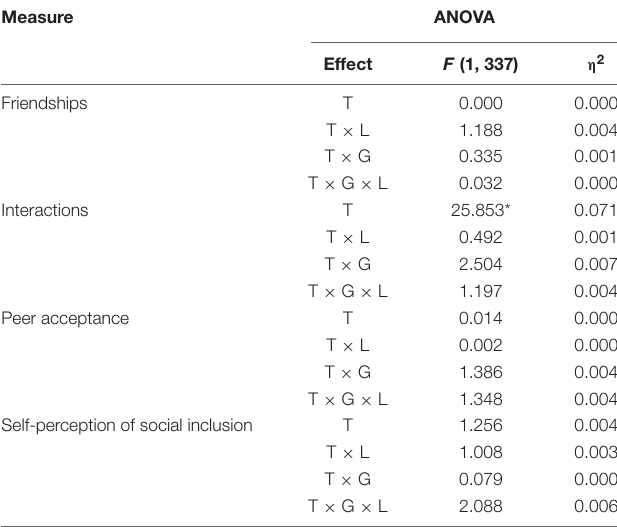
TABLE 11 | ANOVA statistics on the dimensions of social participation. Measure